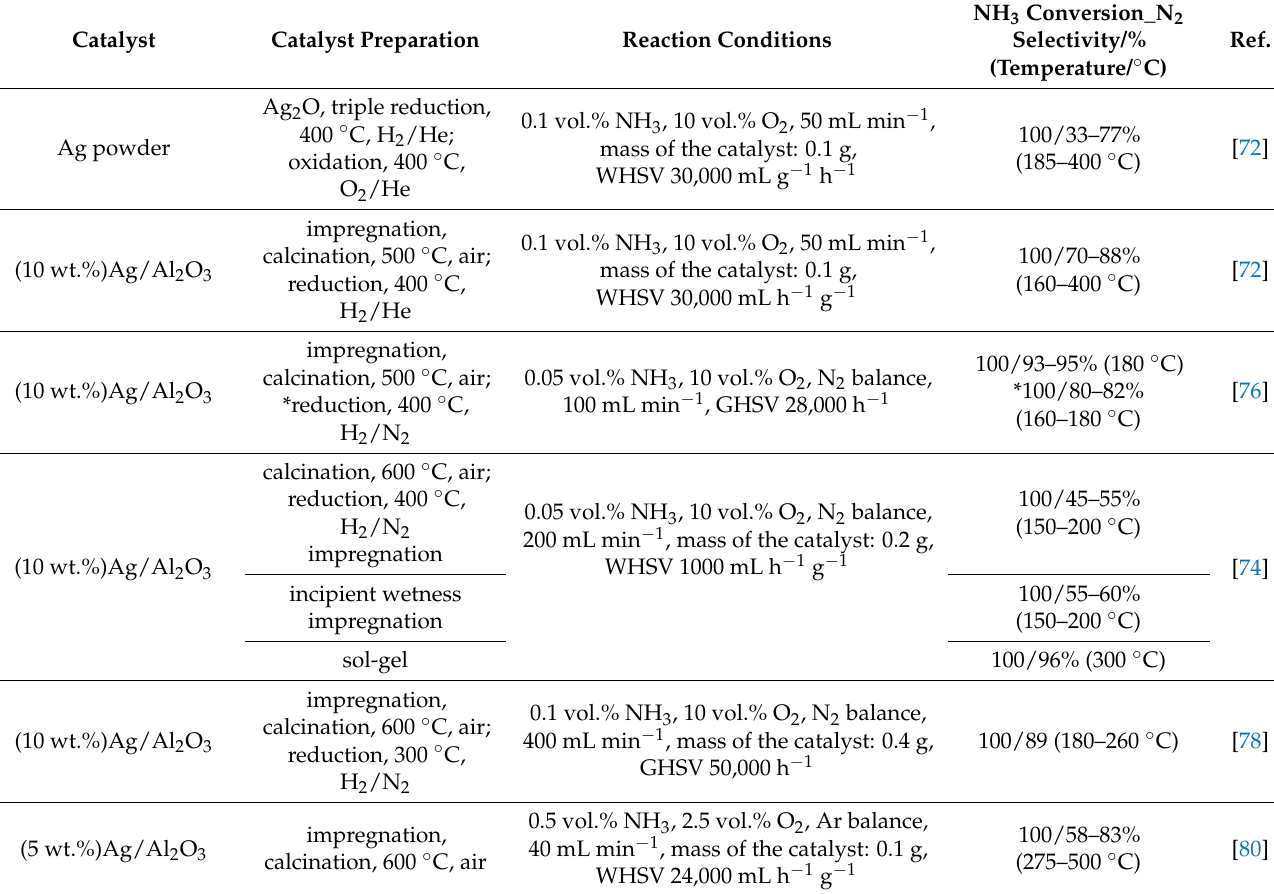
NH 3 Conversion_N 2 Selectivity/% (Temperature/ ◦ C)